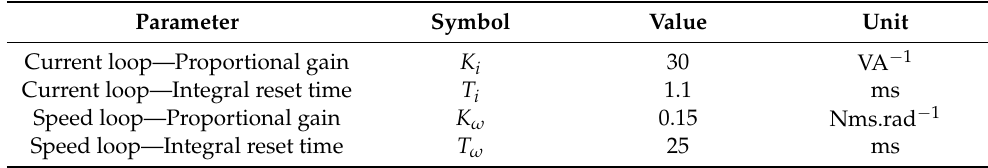
Table A2. Controllers’ settings.